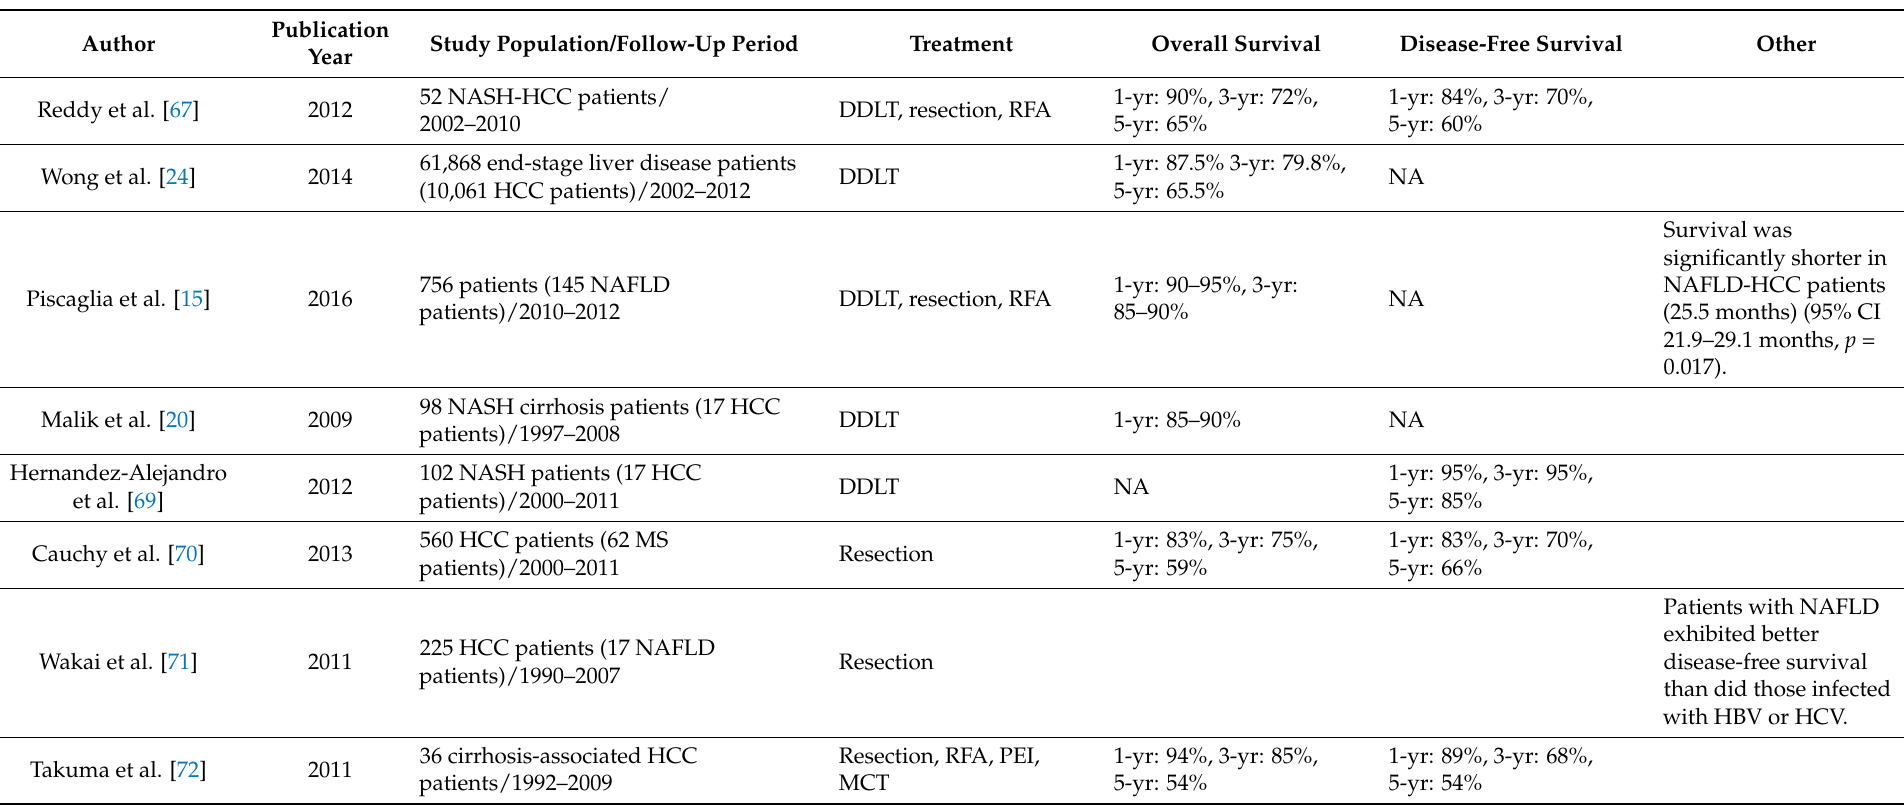
Table 4. Summary of NAFLD-HCC outcomes after curative